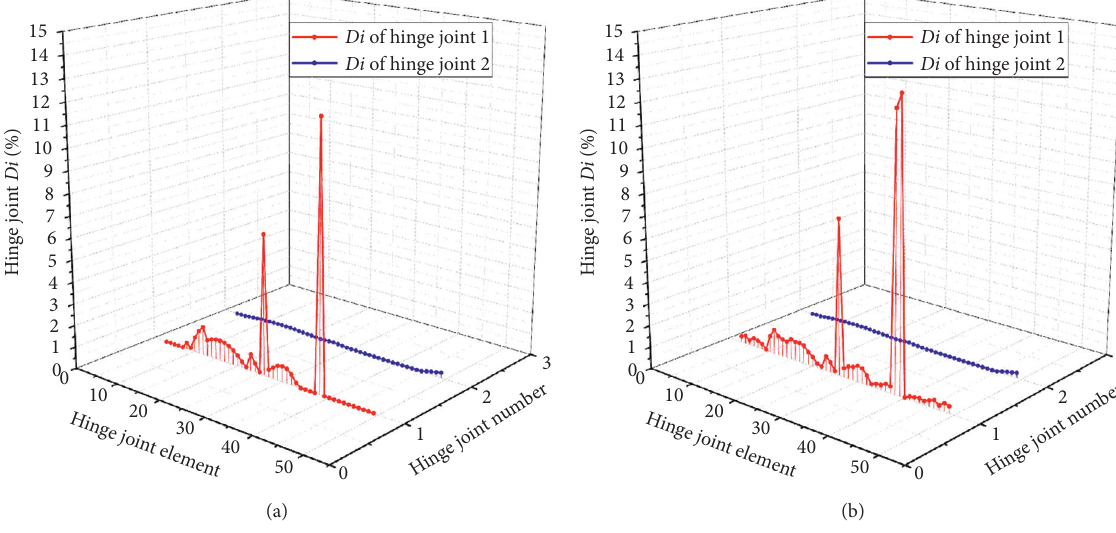
Figure 8: Calculation results of damage degree of hinge joints. (a) Case study 2. (b) Case study